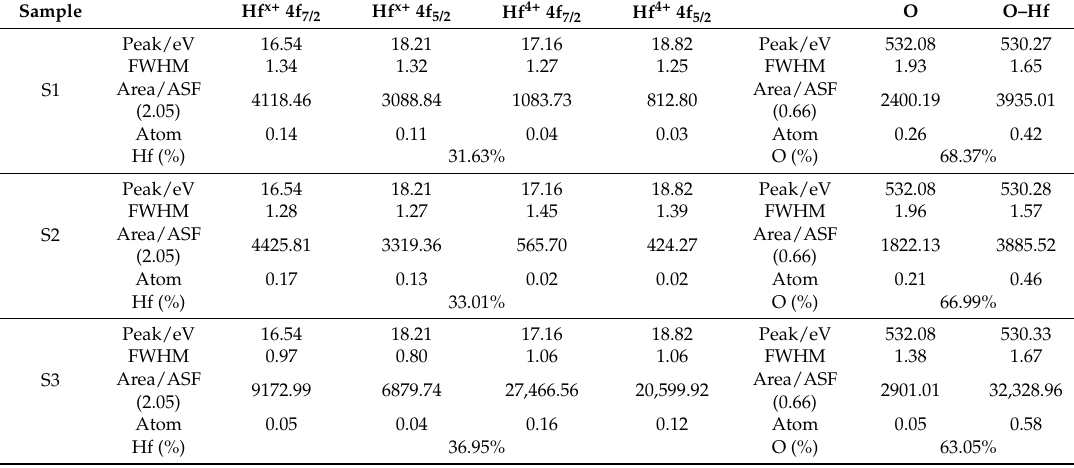
Table 2. The Hf and O atomic percentages and bonding analyses of S1, S2 and